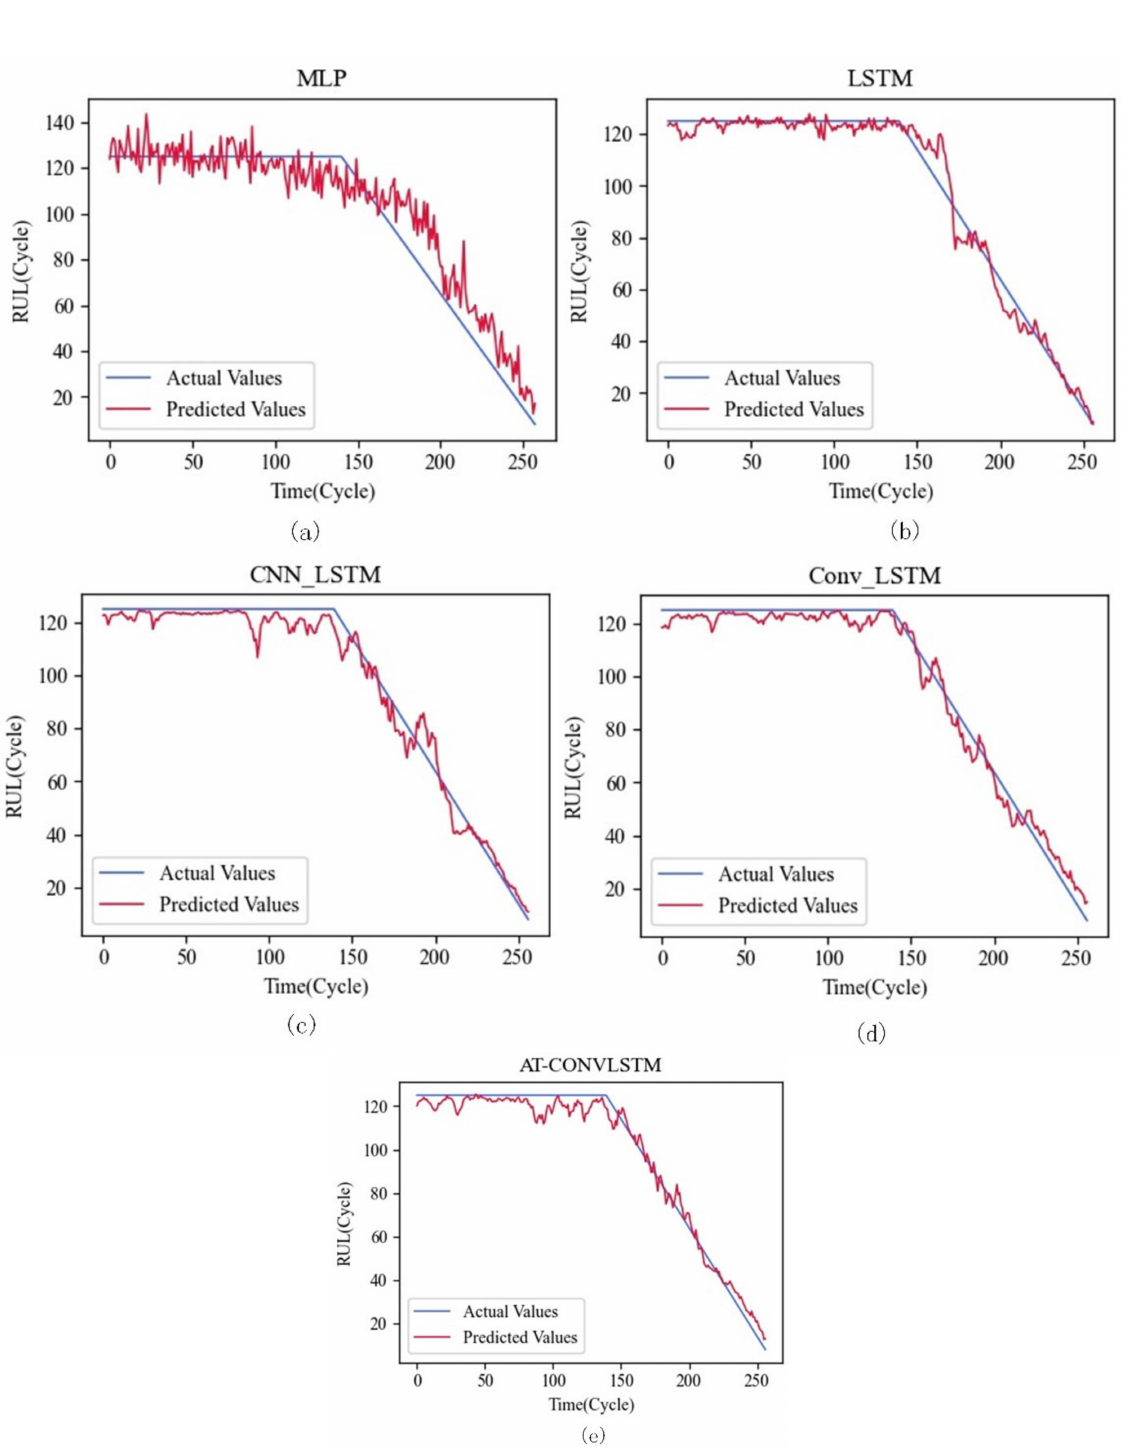
Figure 7. RUL prediction results of FD003: ( a ) MLP; ( b ) LSTM; ( c ) CNN‑LSTM; ( d ) Conv‑LSTM; ( e )